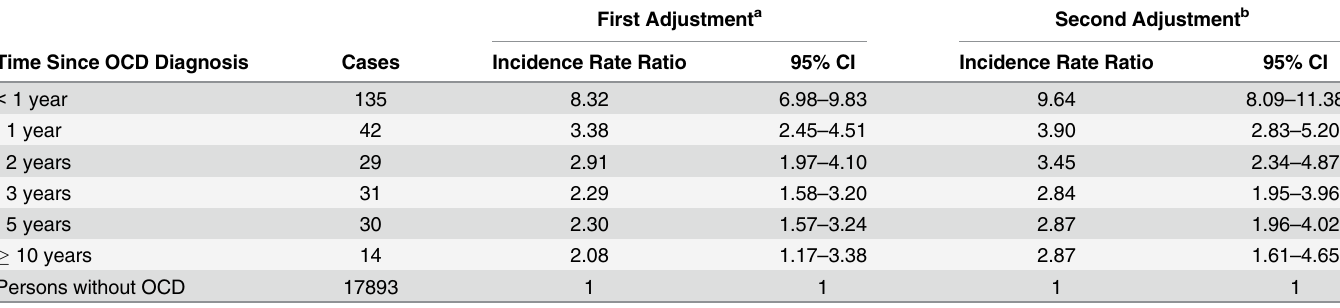
Table 4. Incidence Rate Ratio of Autism Spectrum Disorders in Persons with a Diagnosis of Obsessive-compulsive Disorder (OCD; 1994 –